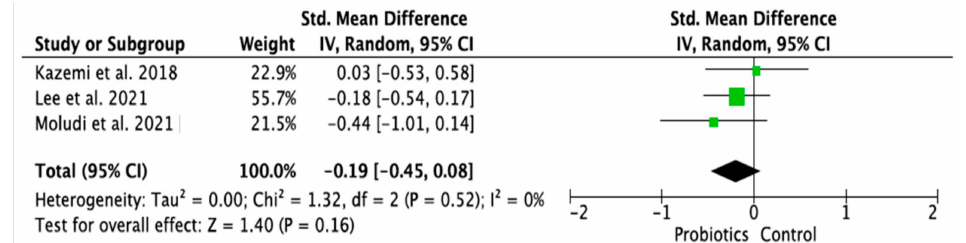
Figure 10. Forest plot for the effect of probiotic treatment on TNF- α level in probiotics and control groups [14,21,31]. Note: The green squares are the SMD for the post-hoc studies, the black rhombus is the graphical summary for all studies above.